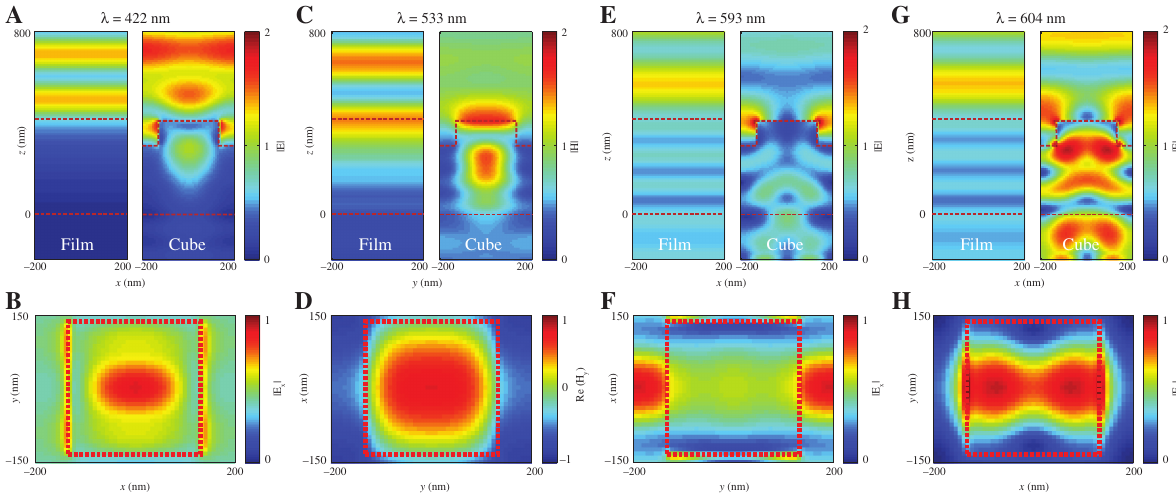
Figure 2: Electric and magnetic field distributions of four different modes. (A) Electric field distributions of the flat film (left panel) and metamaterial (right panel) at the xz -plane with an excitation wavelength of 422 nm. (B) Corresponding electric field distribution of the metamaterial at the xy -plane at the bottom of the nanocube ( z = 300 nm). (C) Magnetic field distributions of the flat film (left panel) and metamaterial (right panel) in the yz -plane with an excitation wavelength of 533 nm. (D) Corresponding magnetic field distribution of the metamaterial at the yx -plane at the bottom of the nanocube. (E–H) Electric field distributions of the flat film (left panel) and metamaterial (right panel) in the xz -plane with the excitation wavelength of 593 nm (E) and 604 nm (G) and the corresponding electric field distributions of the metamaterial at the xy -plane at the bottom of the nanocube at 593 nm (F) and 604 nm (H). Here the HOIP metamaterial has the following structural parameters: t = 300 nm, p = 400 nm, d = 100 nm, and w = 260 nm, while the flat HOIP film has a thickness of 400